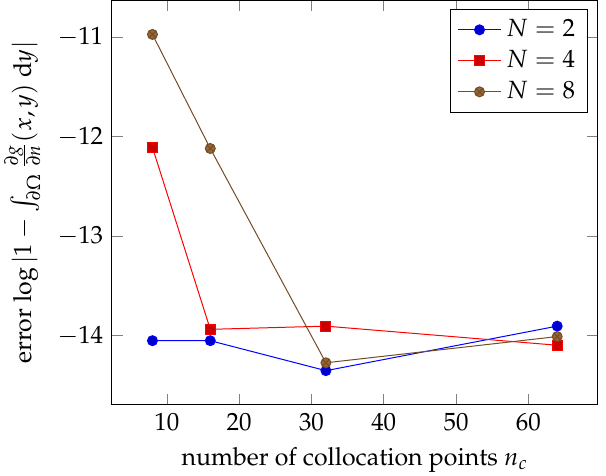
(cid:90) (cid:12) (cid:12) ∂ g (cid:12) (cid:12) ( x , y ) d y − = − 2 and a fixed N for values of n c ranging from 2 to 64 in (cid:12) 1 (cid:12) with x ∂ n ∂ Ω